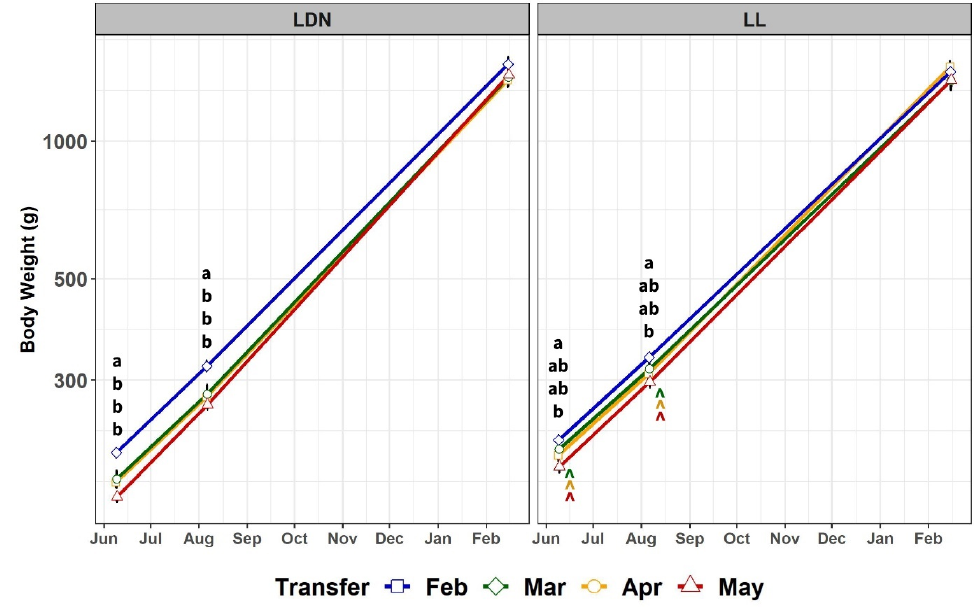
Figure 5. Body weight in the different transfer and photoperiod groups during the period they were all in seawater. The “Y” axis is displayed on a logarithmic scale for better visualization. Photoperiod regimes are displayed separately, with LDN groups on the left and LL groups on the right. Letters “a” and “b” indicate significant differences ( p < 0.05, Tukey post hoc test) at a given sampling between groups transferred to seawater at different months within each photoperiod regime. Colored signs “ˆ” indicate significant differences ( p < 0.05, three-way nested ANOVA) between groups transferred at the same time but that experienced different photoperiods. These signs are located next to the largest of the pair and have the color of the transfer group. Vertical lines indicate SEM.